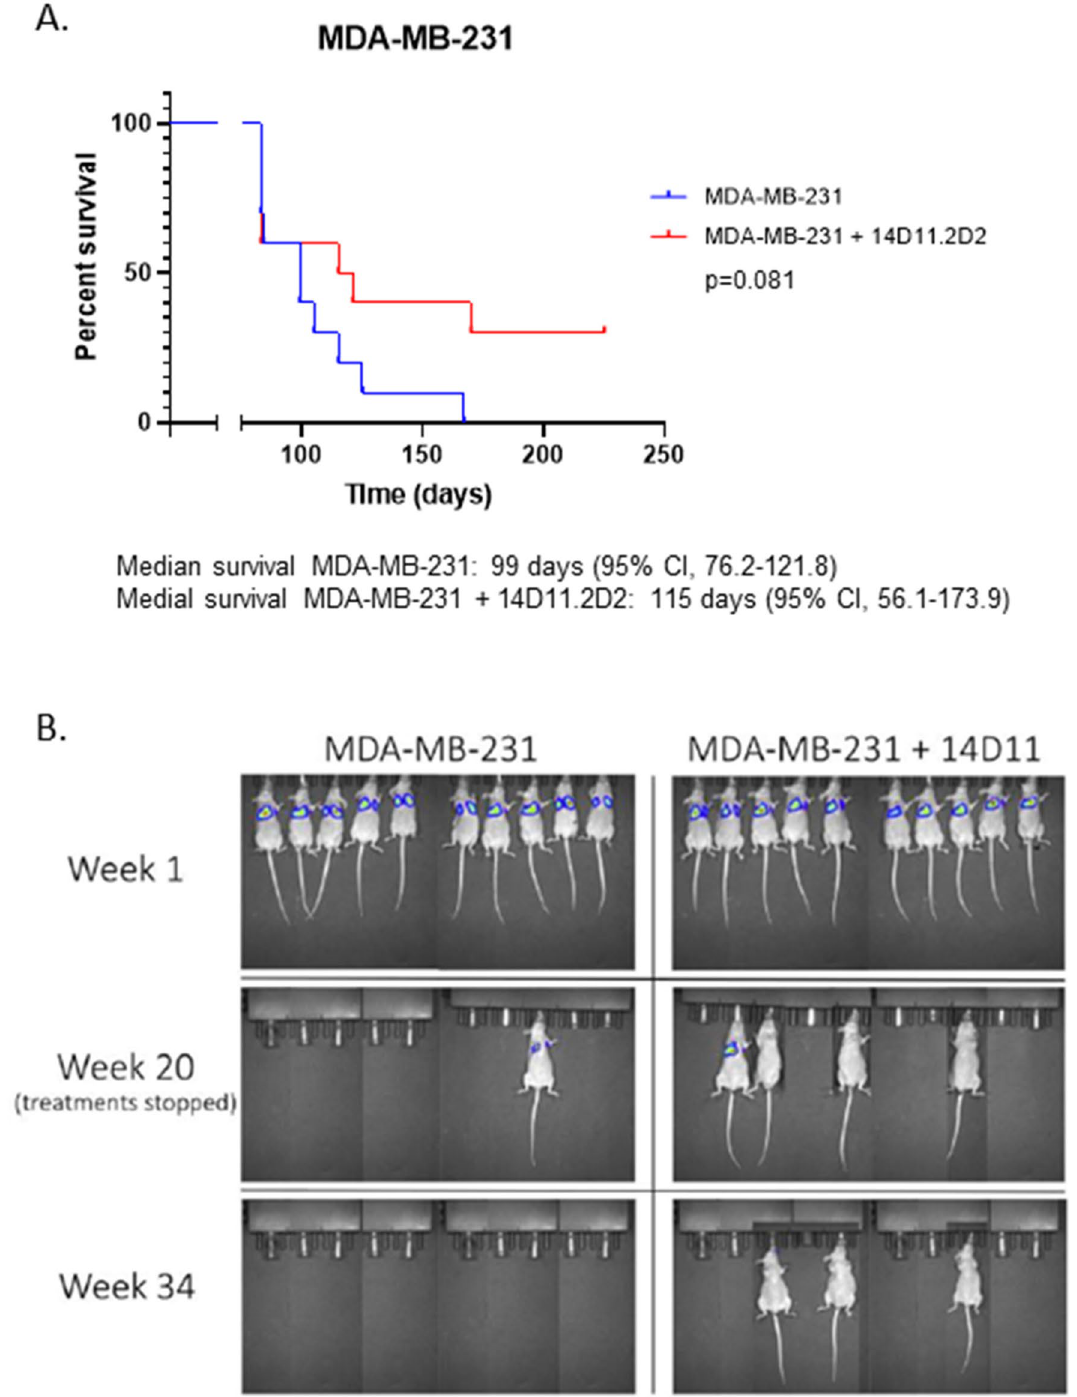
Figure 6. Therapeutic effects of Gal3 blockade on tumor metastases. ( A ) For the mice implanted with MDA-MB-231 cells, median survival for the untreated group was 99 days (95% CI, 76.2–121.8), while for group treated with 14D11, median survival was 115 days (95% CI, 56.1–173.9) ( p = 0.081). ( B ) Representative luminescence images of mice at 1, 20, and 34